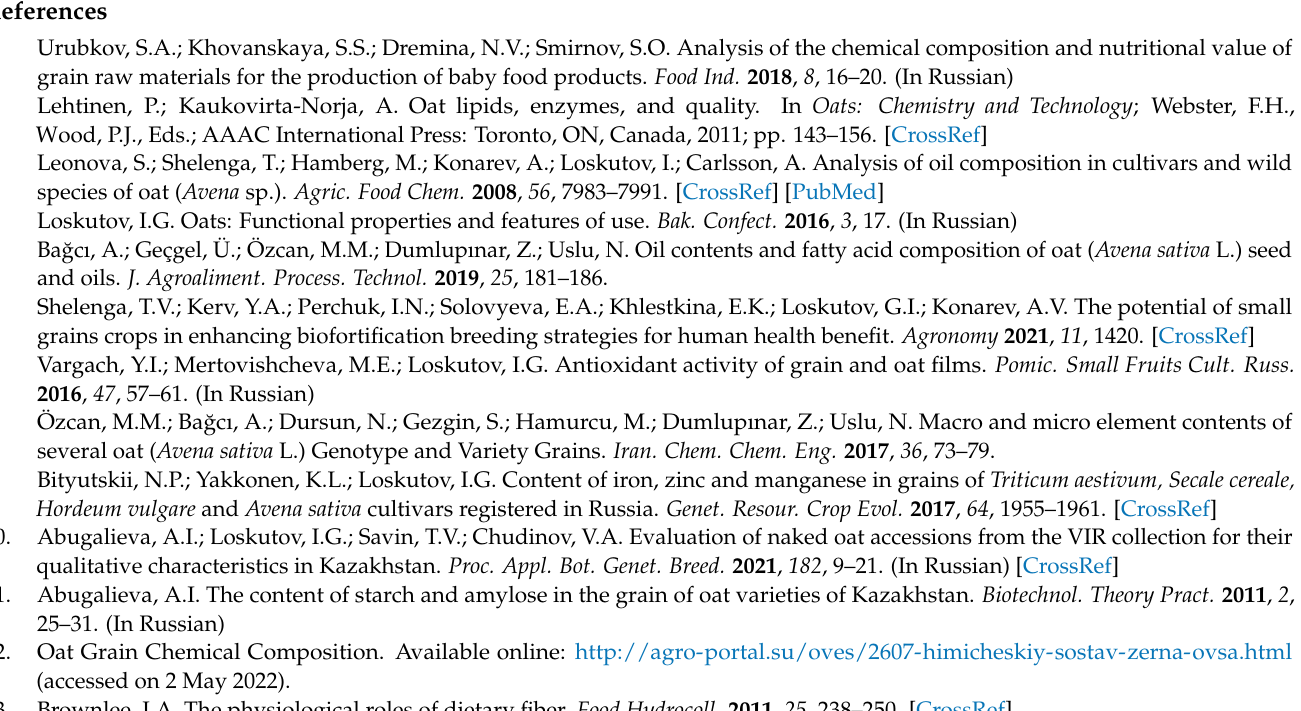
in the grain of Avena L. cultivars from the VIR